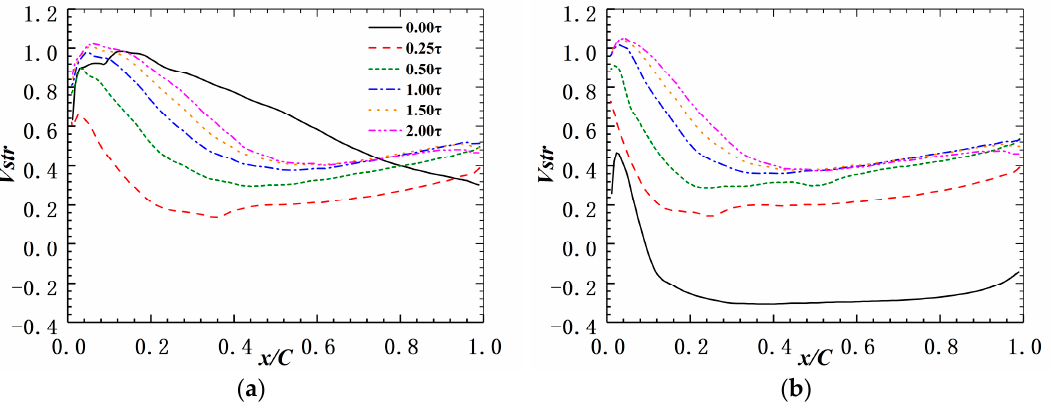
Figure 11. Distribution of the normalized streamwise component of leakage flow velocity at the suction side of the stator hub gap along the blade chord. ( a ) In the DE condition; ( b ) in the NS condition.